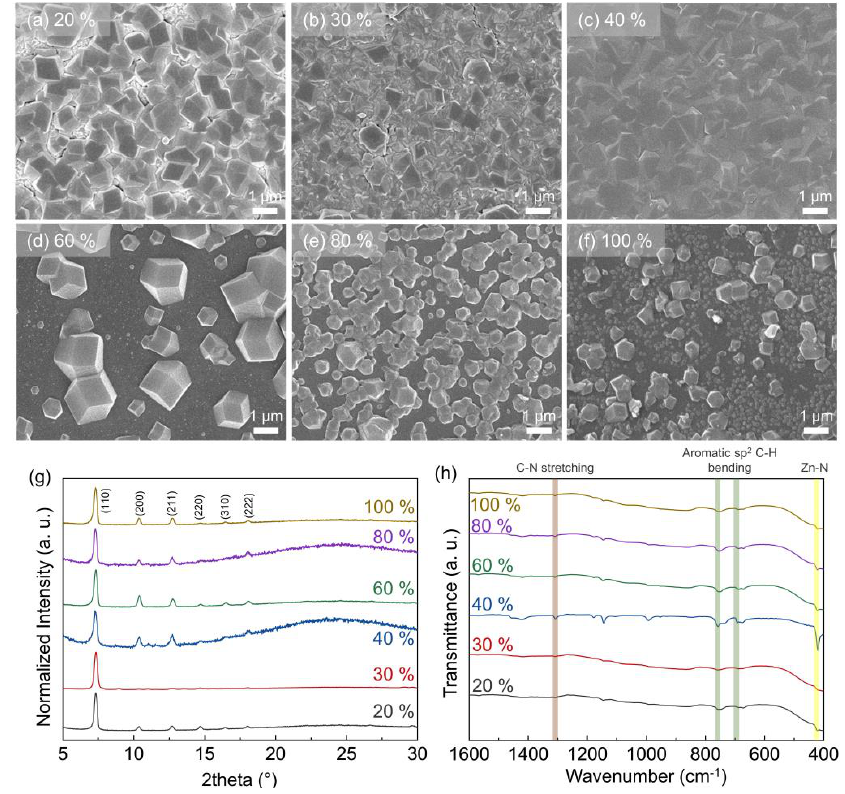
Figure 1. ( a – f ) SEM images (( a ): 20%, ( b ): 30%, ( c ): 40%, ( d ): 60%, ( e ): 80%, and ( f ): 100%). ( g ) XRD patterns and ( h ) FT-IR spectra of ZIF-8 crystals depending on relative humidity (20, 30, 40, 60, 80, and 100%). The temperature of the chamber was 50 °C.